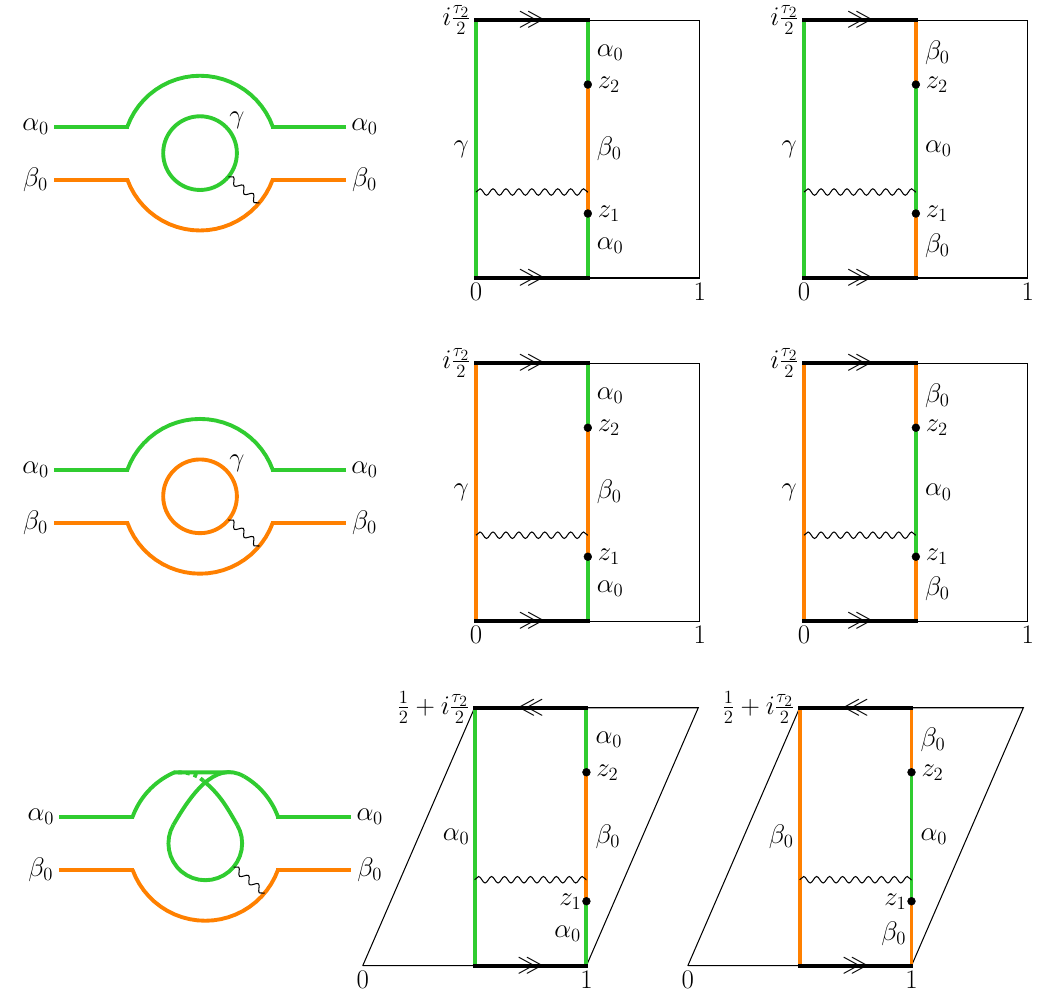
Figure 3. Open-string diagrams with two external legs in the ND and DN sectors (left panel). On the double-cover tori (center and right panels), the external legs are mapped to boundary-changing vertex operators at z 1 , z 2 . One switches from center to right panel by transporting z 2 along the entire edge it belongs